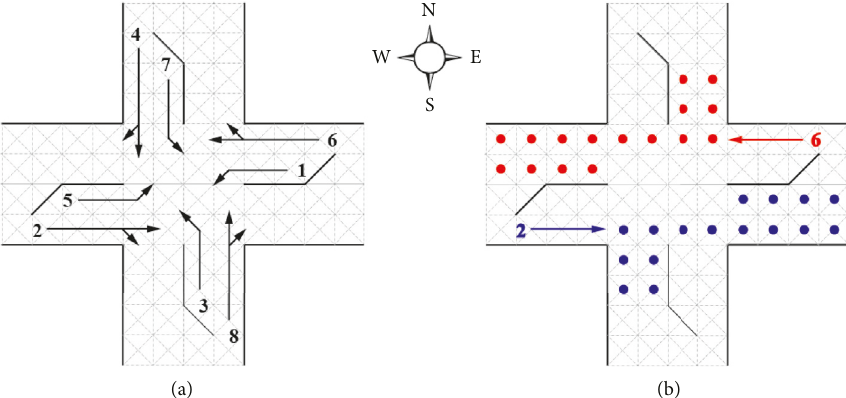
Figure 3: (a) Traffic flows at the intersection. (b) The sites with dots show the movable set for the phase sequence 𝑃 26